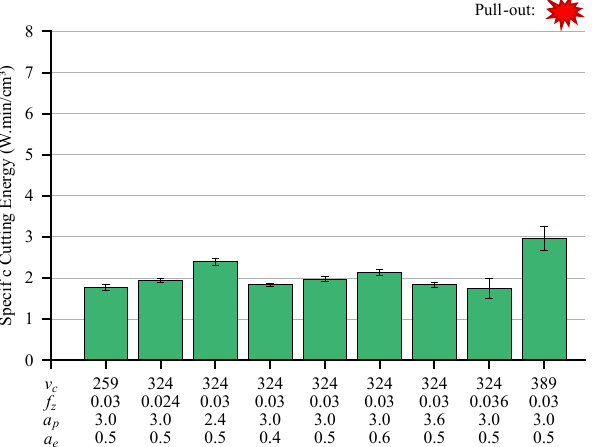
Figure 11. Qualification test of the composite tool, the evolution of W c (W · min/cm 3 ) for different v c (m/min), f z (mm/tooth), a p (mm), and a e (mm). No material pull-out was observed.